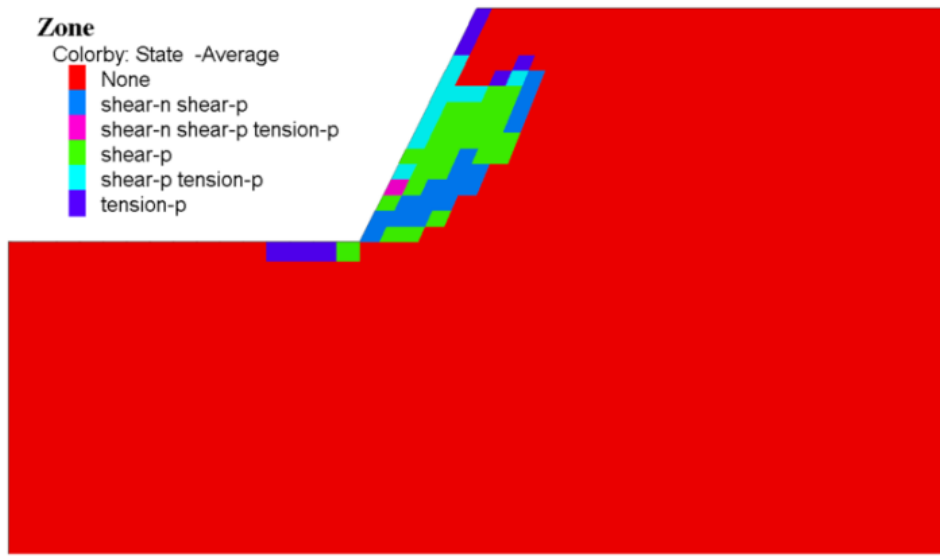
Figure 8. The plastic zone of model 2 after the third excavation.